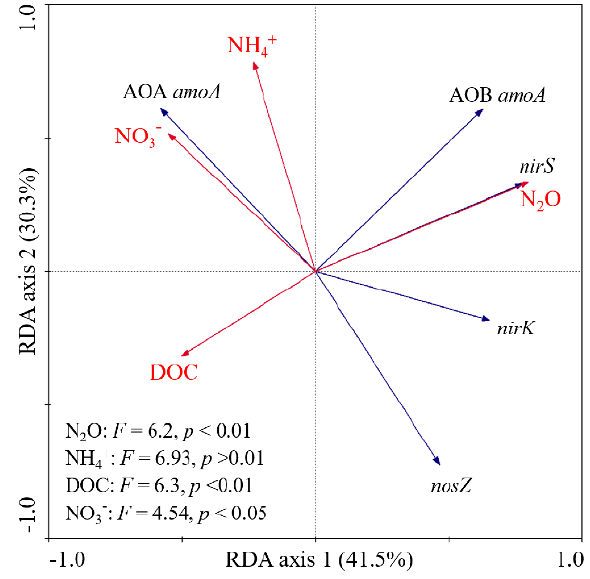
Figure 4. RDA ordination diagram of the relationships between cumulative N 2 O emissions and soil chemical variables (DOC, NH 4+ , and NO 3 − ) with functional genes related to N 2 O (AOA amoA , AOB amoA , nirK , nirS , and nosZ ).